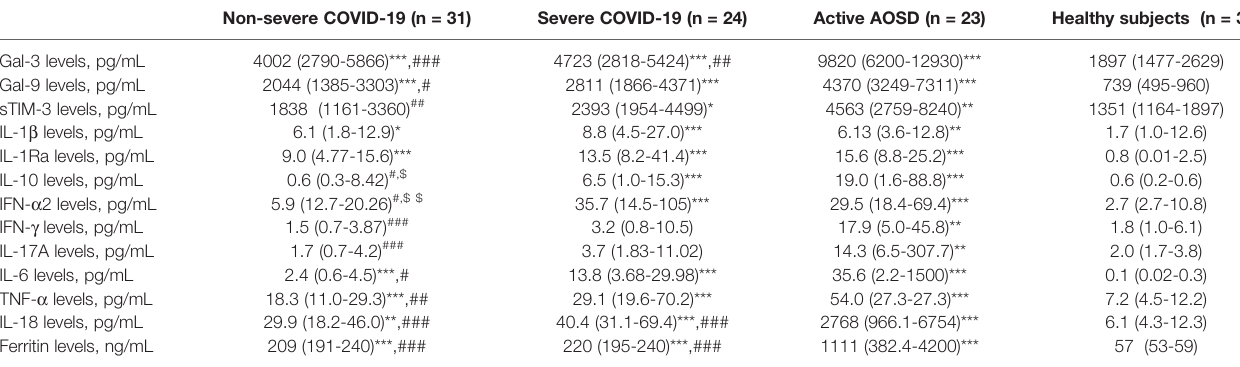
TABLE 2 | Plasma levels of galectins, cytokine pro fi les, and ferritin in COVID-19 patients, active AOSD patients, and healthy subjects.